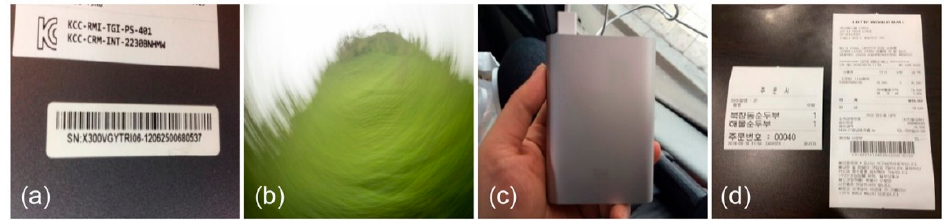
Figure 6. Example of photos in “difficult to classify” scene: ( a ) barcode photo; ( b ) no meaning photo; ( c ) zoom-in photo of an electronic device; and ( d ) receipts photo.